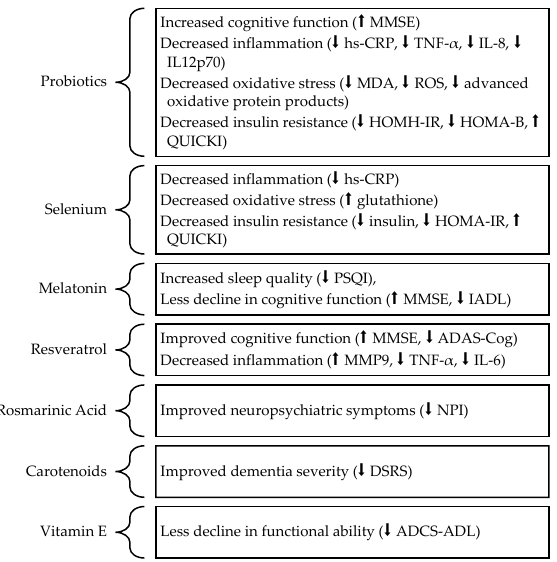
Figure 1. The potential beneficial effects of different antioxidant supplements in individuals with AD. Upward arrows ( ⬆ ) indicate that the beneficial relationship results from the indicated value increasing, while downward arrows ( ⬇ ) indicate that the beneficial relationship results from the indicated value decreasing. Abbreviations: AD, Alzheimer’s disease; ADAS-Cog, Alzheimer’s Dis-